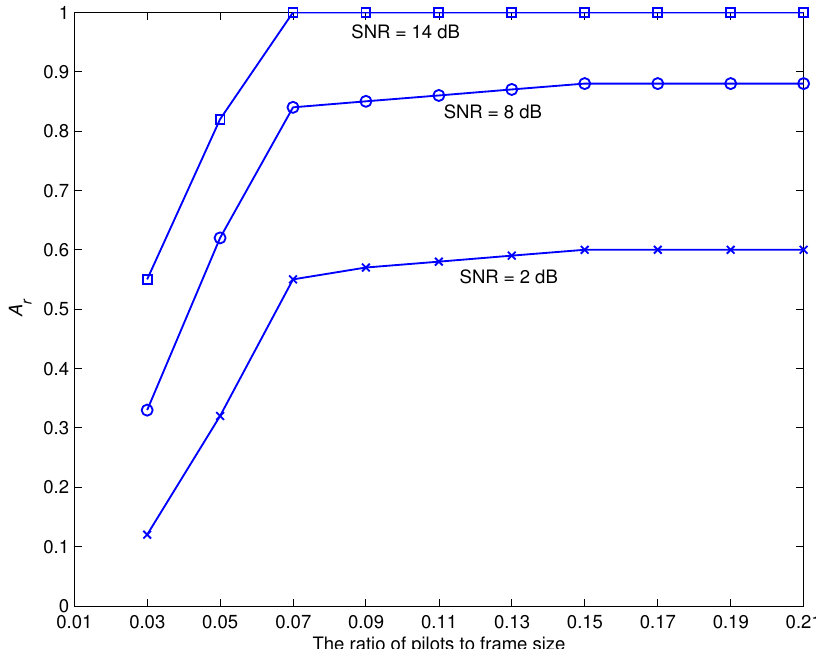
Figure 4. The influence of the number of pilots relative to the frame size with six